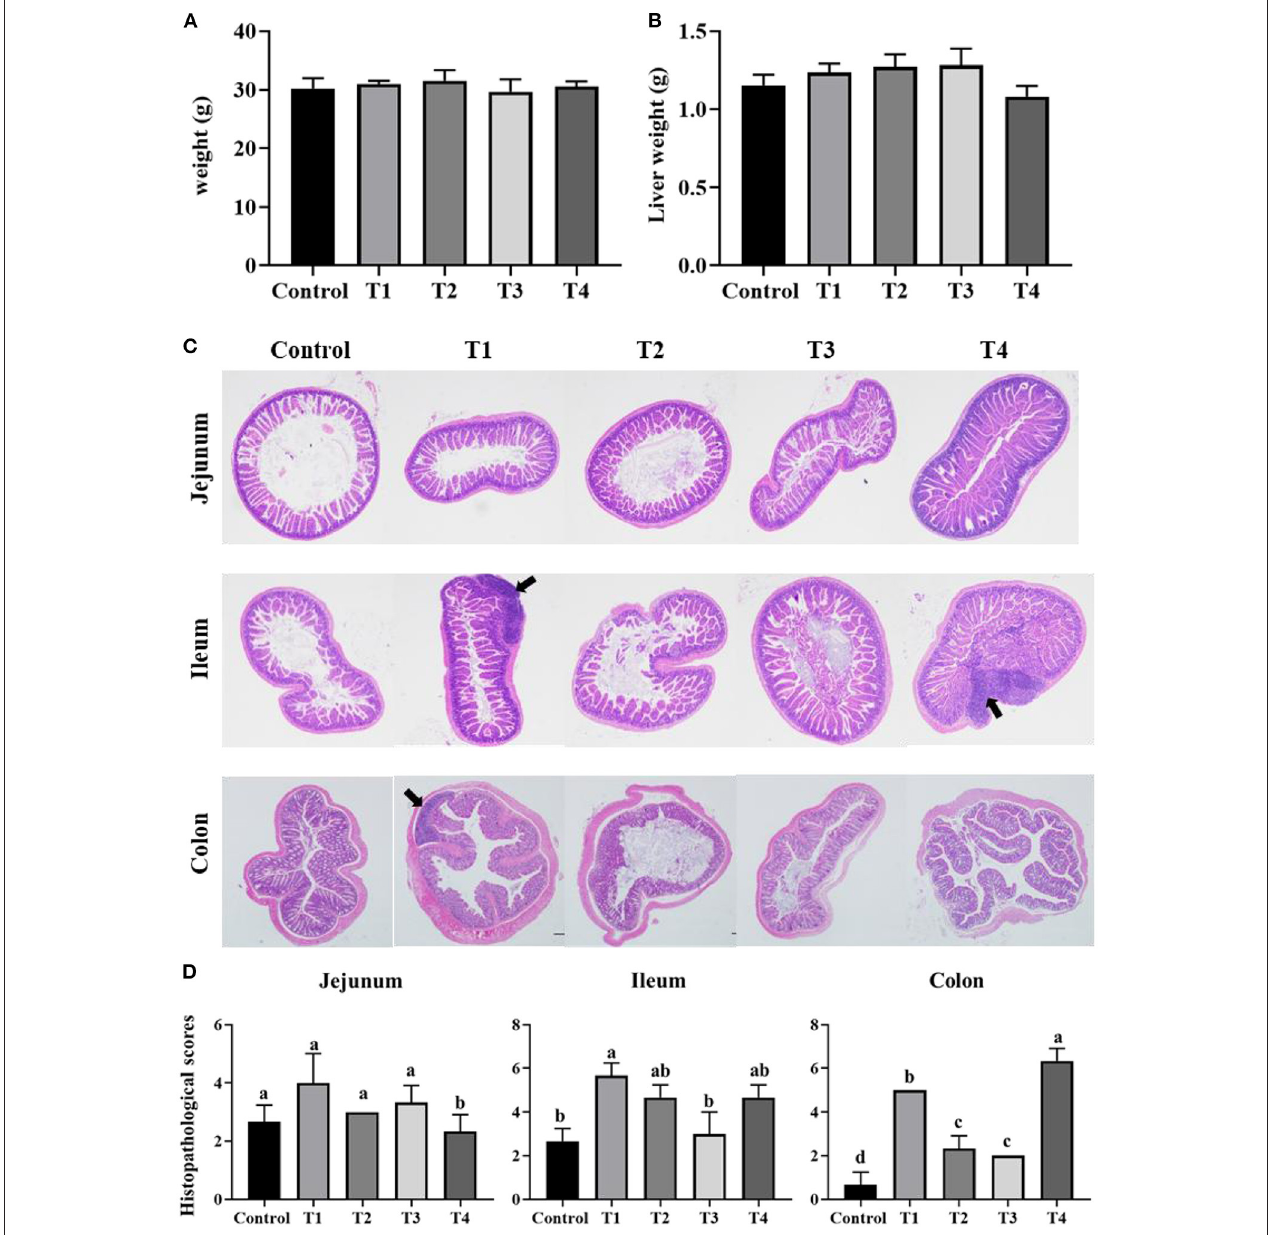
FIGURE 1 | Bar chart showing the mice body weight (A) and liver weight (B) . Representative H&E-stained sections from jejunum, ileum, cecum and colon (C) , the arrowhead points in the direction where lymphocyte aggregation. Histopathological scores of the H&E staining (D) . Data was expressed as mean ± SEM ( n = 8) and analyzed by one-way ANOVA analysis. The different superscript letters on the histogram represent a significant difference (D) ( P < 0.01).